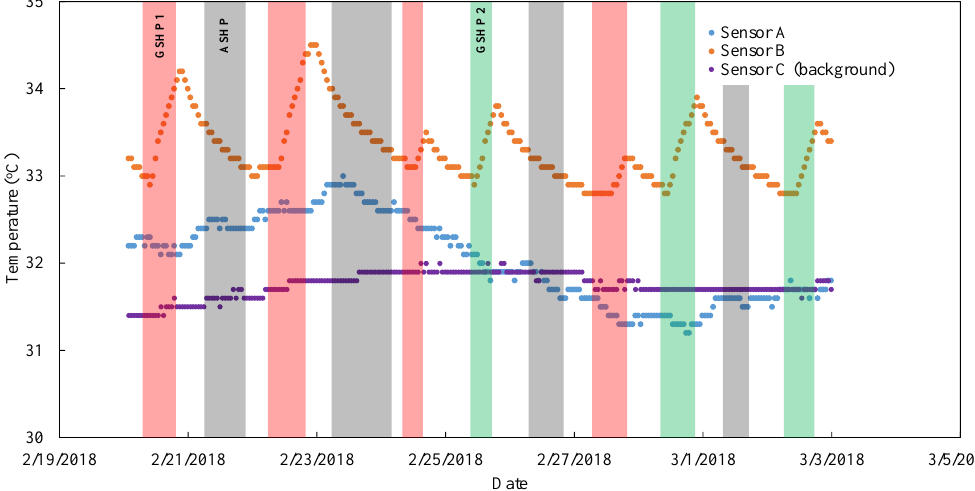
Figure 18. Ground temperatures during heat pump operation (February 20–March, 3).